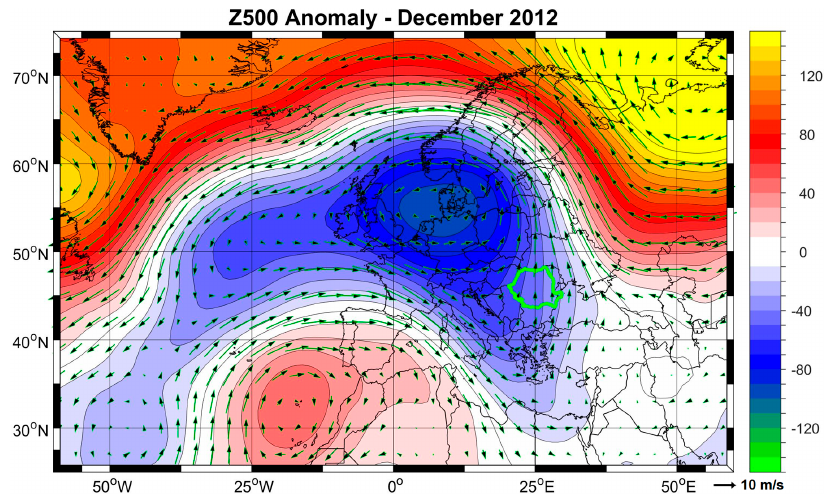
Figure 7. Geopotential height anomalies at 500 mb level (Z500) the events in December 2012.